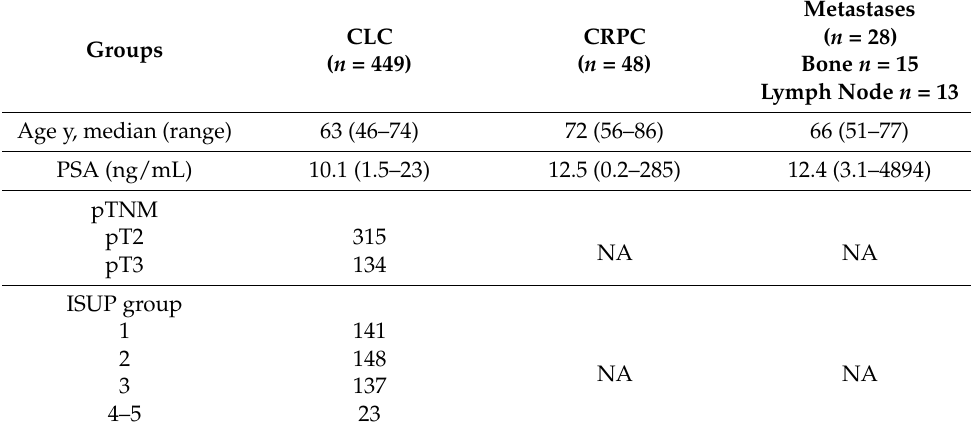
Table 1. Patients and tissues